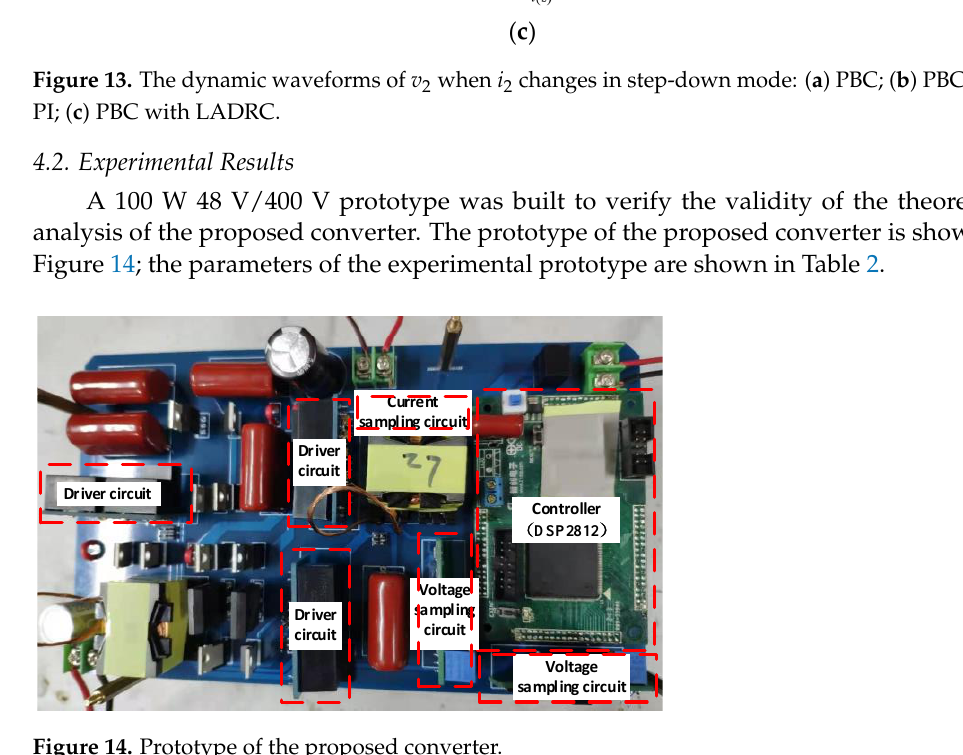
Table 2. Parameters of an experimental prototype. Figure 13. The dynamic waveforms of v 2 when i 2 changes in step-down mode: ( a ) PBC; ( b ) PBC with PI; ( c ) PBC with LADRC. PI; ( c ) PBC with LADRC.